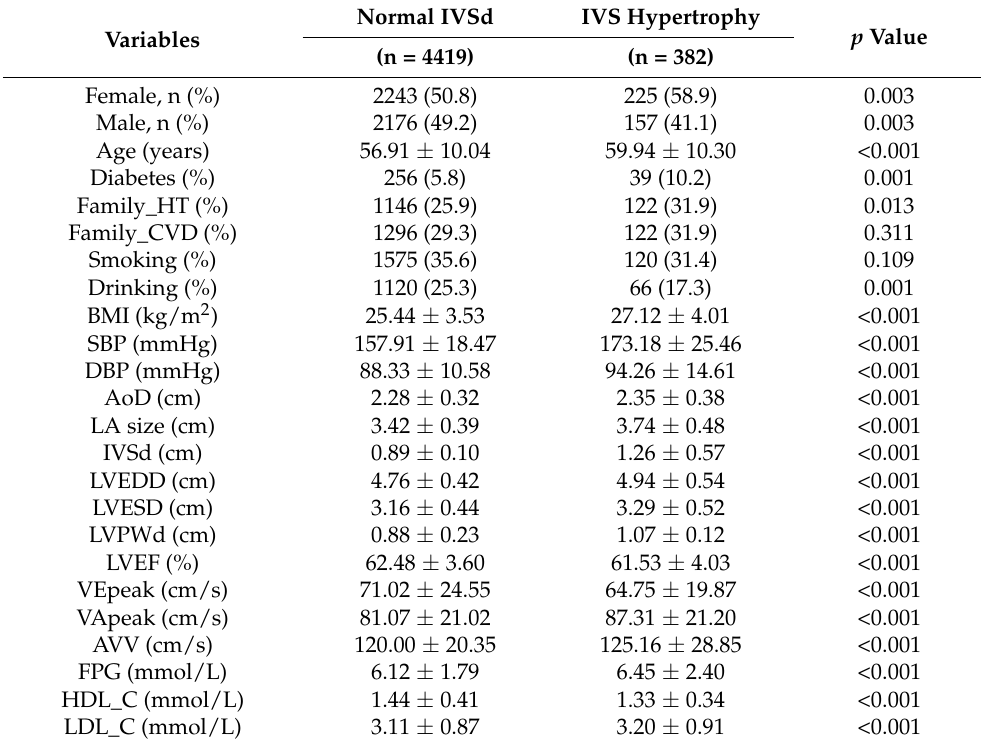
Table 1. Baseline information of study